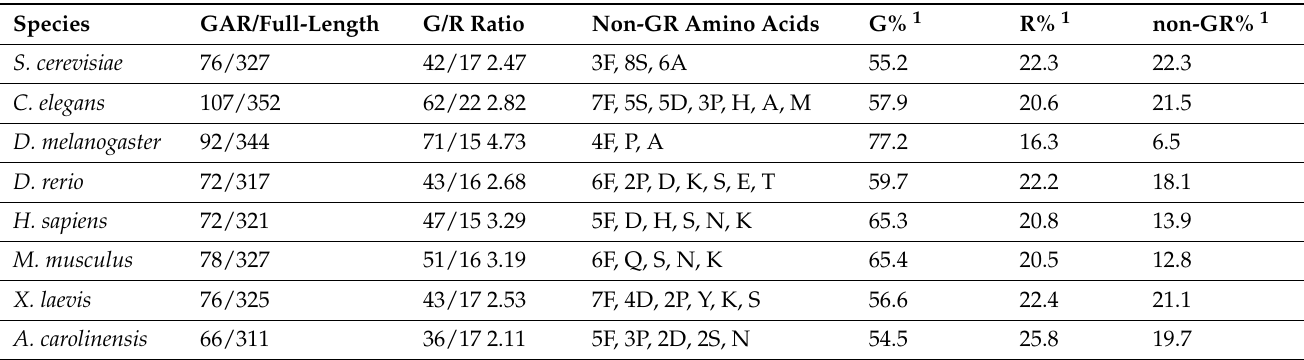
Table 1. The length, number of G/R residues and amino acids besides GR in the GAR domain of FBL in model